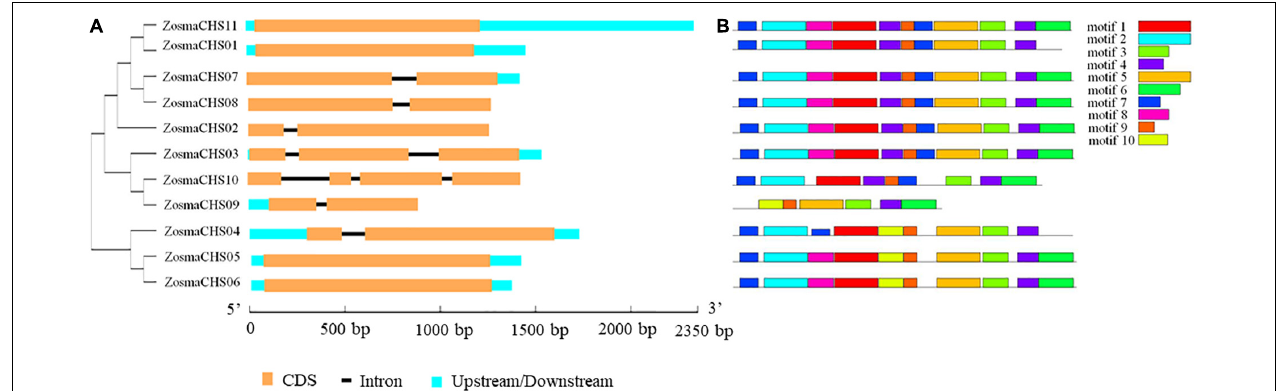
FIGURE 1 | Gene structure and motifs compositions of ZosmaCHS proteins. (A) Gene model of CHS genes in Z. marina . Blue boxes indicate untranslated regions, black lines indicate introns and yellow boxes indicate exons. (B) The motif compositions of ZosmaCHS proteins. The motifs 1–10 are displayed in different colored boxes. The sequence information for each motif is shown in Supplementary Table 4 .